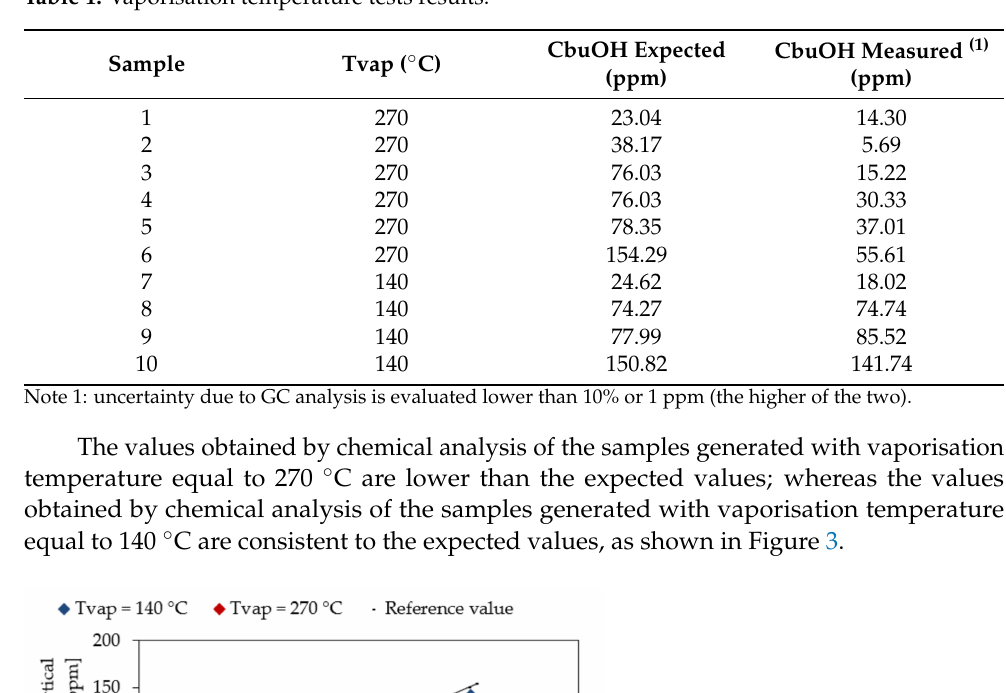
Table 1. Vaporisation temperature tests results.